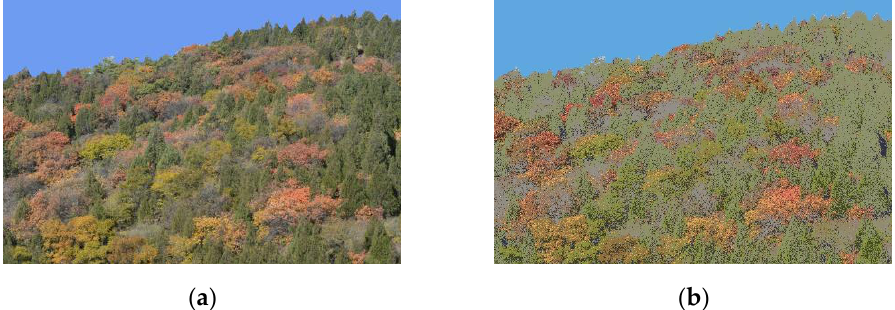
Figure 3. Visualization of Cotinus coggygria var. cinerea Engl. forest photograph. ( a ) The original landscape photograph; ( b ) the photograph after color quantization.